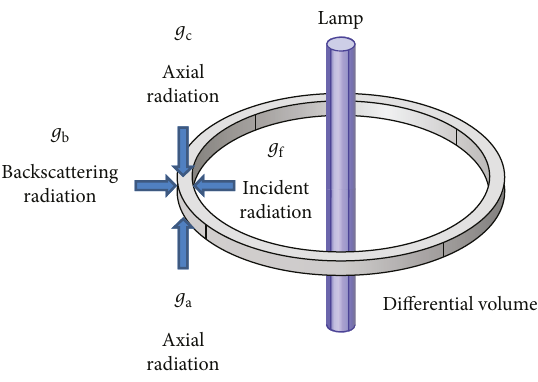
Figure 2: Directions of the fl uxes of photons in the four- fl ux